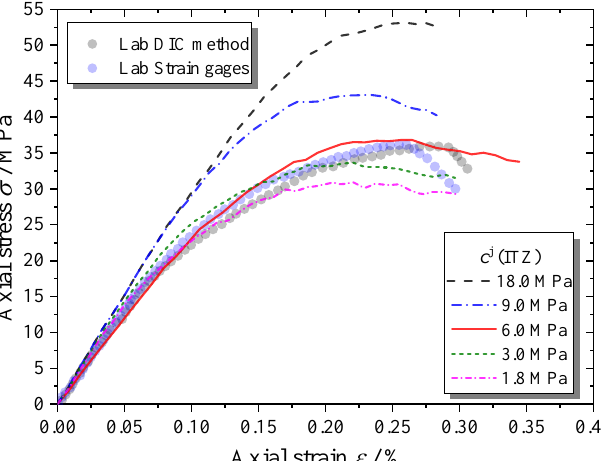
Figure 24. Complete compressive stress–strain curves of MRAC specimens with various ITZ shear strength values.